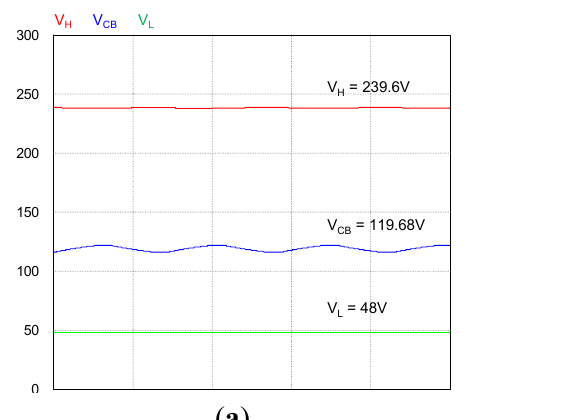
Figure 18. Waveforms of open-circuit voltage of switches Q 1 ~ Q 4 in the charge mode at full load ( a ) by simulation; and ( b ) by measurement.